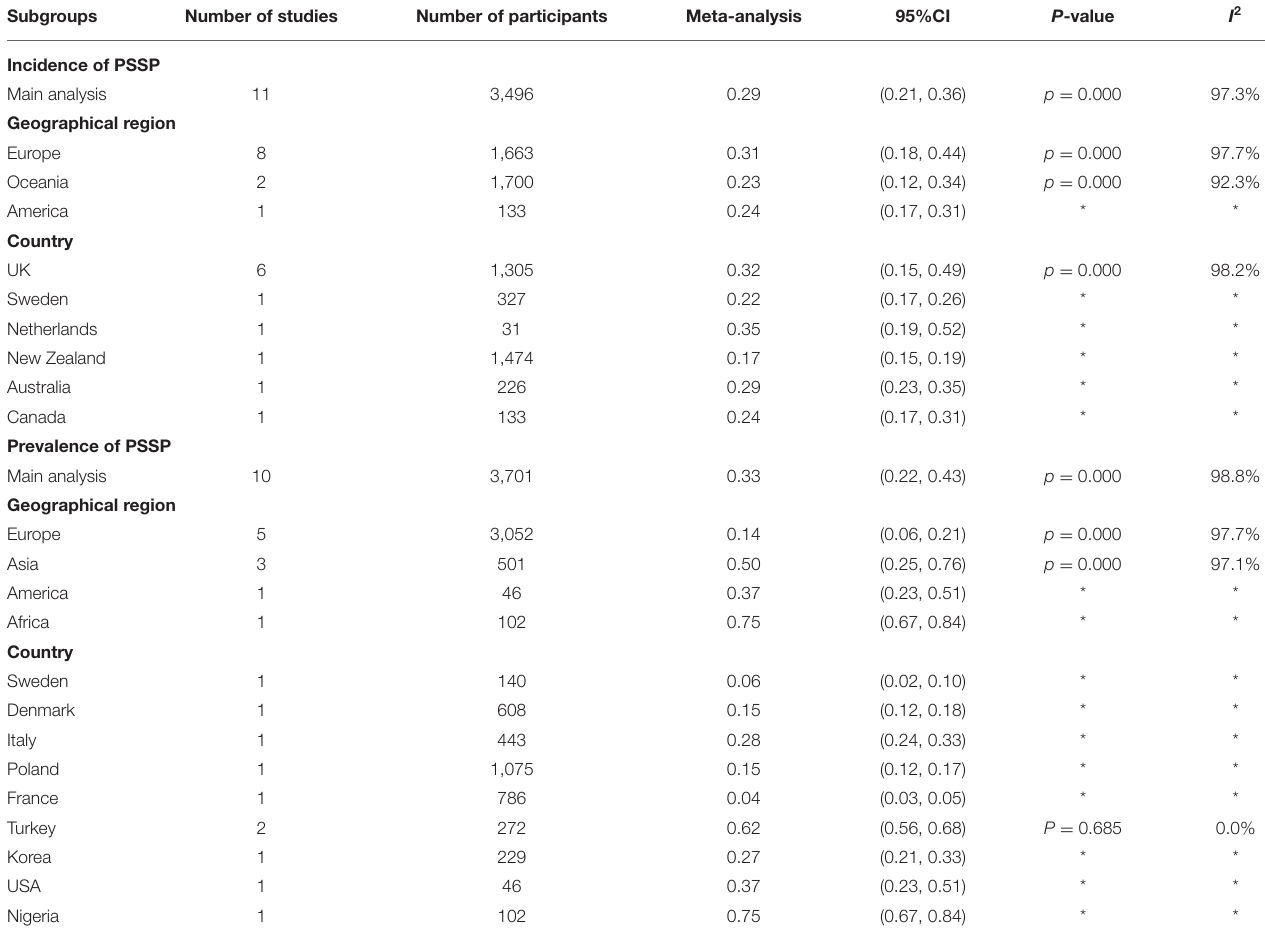
TABLE 5 | Subgroups analysis of incidence and prevalence PSSP.